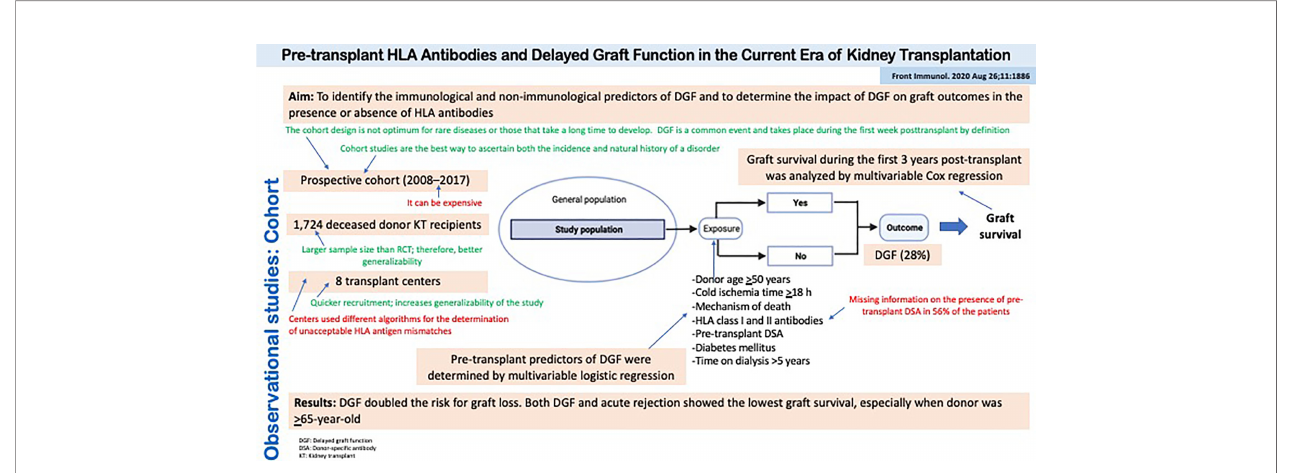
FIGURE 5 | Observational studies: Cohort. Pre-transplant HLA Antibodies and Delayed Graft Function in the Current Era of Kidney